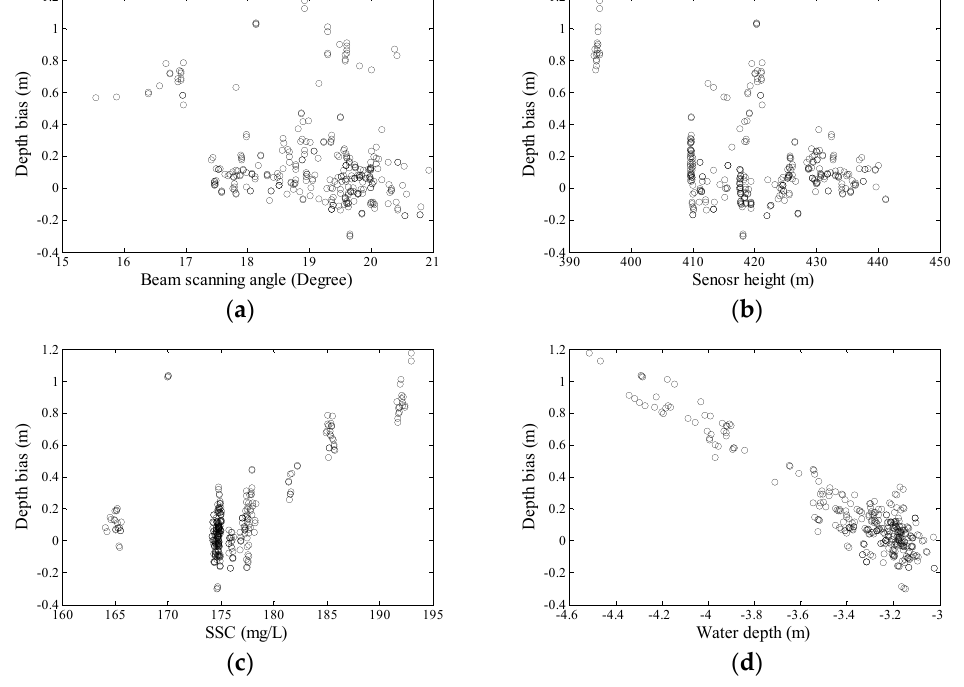
Figure 3. Depth bias ∆ d obtained by comparing H BALB and H BSonar at the same location Equation (9) changes with different parameters. ( a – d ) denote depth biases changing with beam scanning angle, sensor height, SSC, and water depth, respectively.